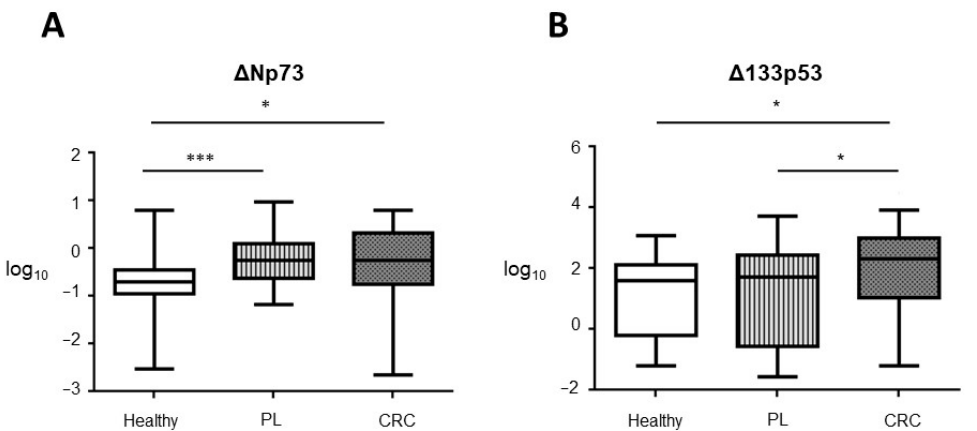
Figure 2. EVs’ mRNA levels of ( A ) ∆ Np73 and ( B ) ∆ 133p53 in the three groups of individuals. Box and whisker plot